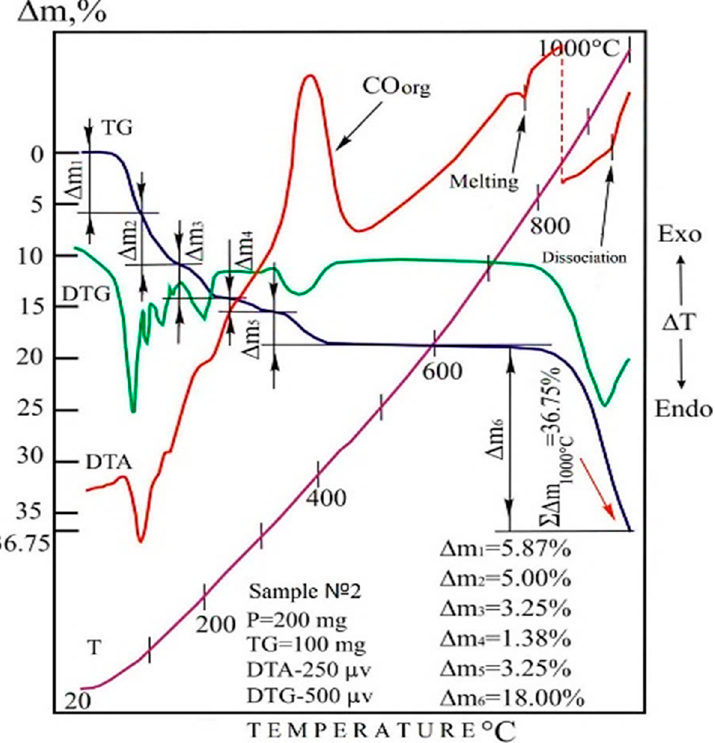
Figure 5. Thermogravimetric readings of the charge 100 lead sludge: 30 sodium sulfates; 5 cokes at 20–1000 °C at 40–85 °C change in sample mass ∆ m 1 = − 5.87% ‐ H 2 O; at 85–155 ° С — ∆ m 2 = − 5% ‐ H 2 O; at 155–240 ° С — ∆ m 3 = − 3.25% ‐С O 2 ; ‐ H 2 O; at 240–320 ° С — ∆ m 4 = 1.38 ‐С O 2 ;—SO 2 ; at 320–430 ° С — ∆ m 5 = − 3.25% ‐С O 2 ; at 740–1000° С — ∆ m 6 = − 18%—SO 2 , sublimation; and at 20–1000 °C sample mass change in total ∆ m= − 36.75%.